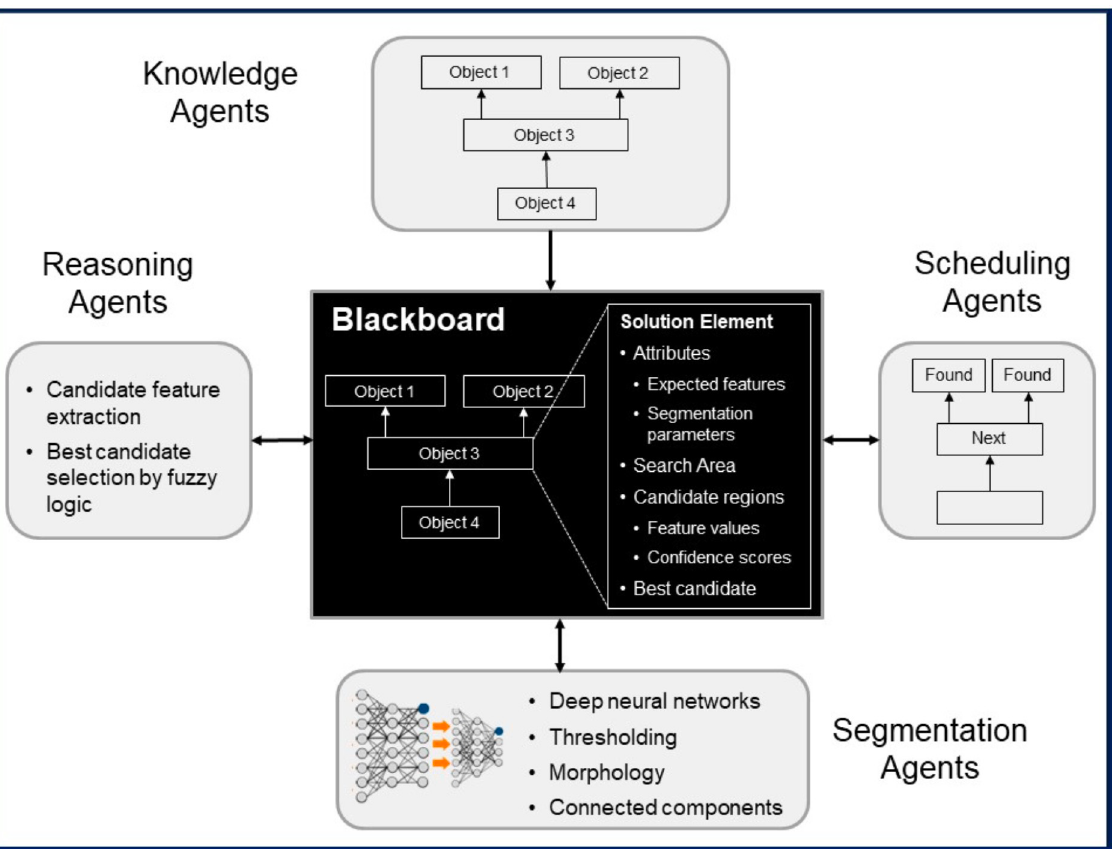
Fig 1. SimpleMind multi-agent thinking architecture. Schematic showing agent types and the Blackboard for sharing of results during image understanding.